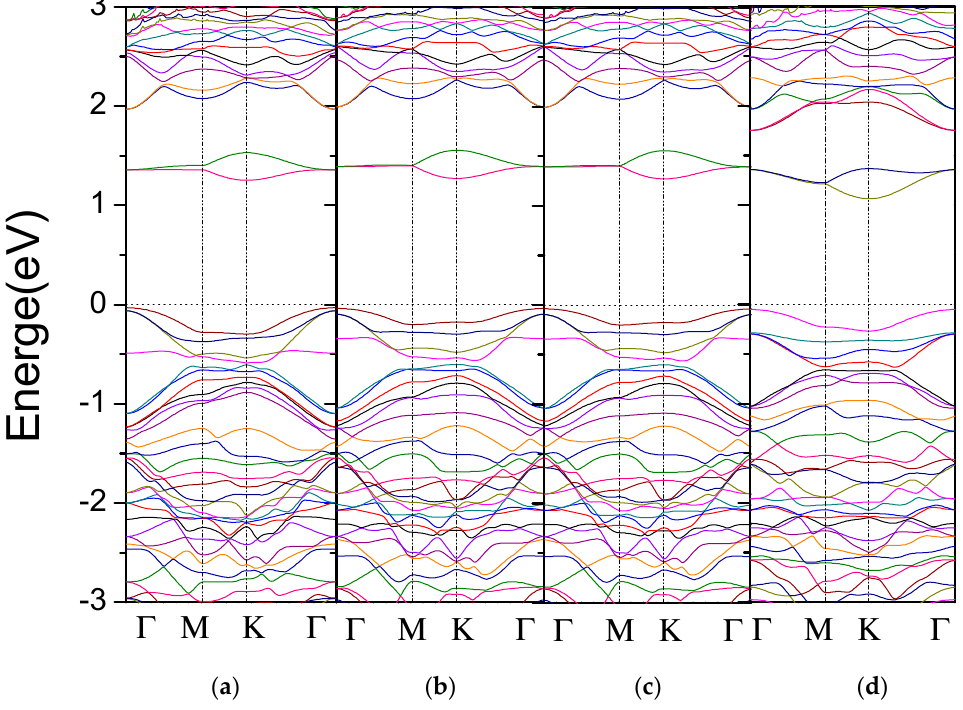
Figure 5. Band structure of a 3 × 3 × 1 WS 2 monolayer with ( a ) V S ; ( b ) V S -O; ( c ) V 2S and ( d ) V 2S -O. The V X -O (X = S, 2S) means 1-O atom doped WS 2 monolayer with V X types of vacancy defects.